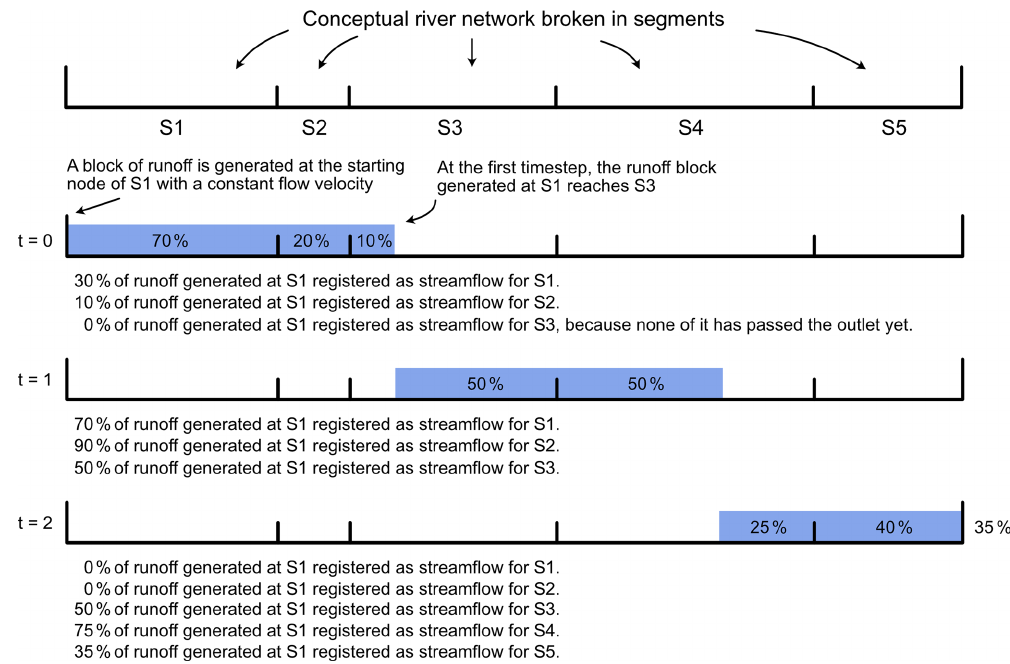
Figure B1. Conceptual representation of the constant velocity algorithm, showing runoff produced at S1 at time step t = 0 and how it is registered at downstream river